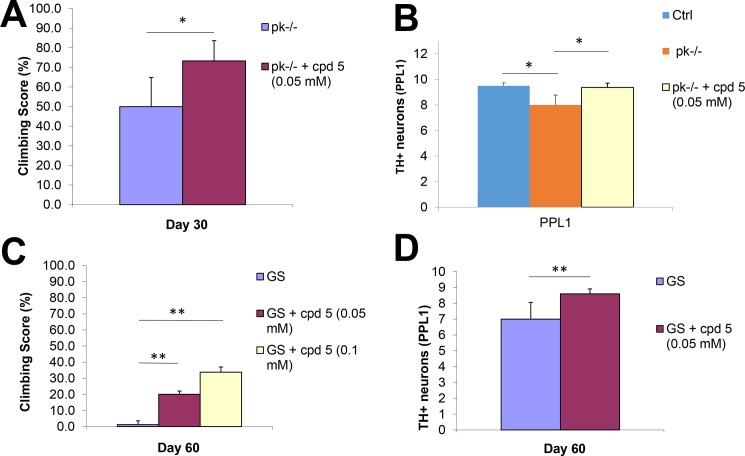
Treatment of compounds 5 in both parkin-null (A and B) and mutant LRRK2 G2019S-expressing (C and D) flies. A: Climbing score of untreated and compound 5 (50 μM)-treated parkin-null flies (where 100% is the climbing score of normal flies). B: DA neuronal count (PPL1 cluster) of normal flies (control), parkin-null flies, and compound 5 (50 μM)-treated parkin-null flies. C: As in A, except that parkin-null flies were substituted with LRRK2 G2019S-expressing flies (the control is represented by the mutant flies). Two concentrations, 50 μM and 100 μM, of compound 5 were tested. D: As in B, except that parkin-null flies were substituted with LRRK2 G2019S-expressing flies. (*p < 0.05, **p < 0.01).